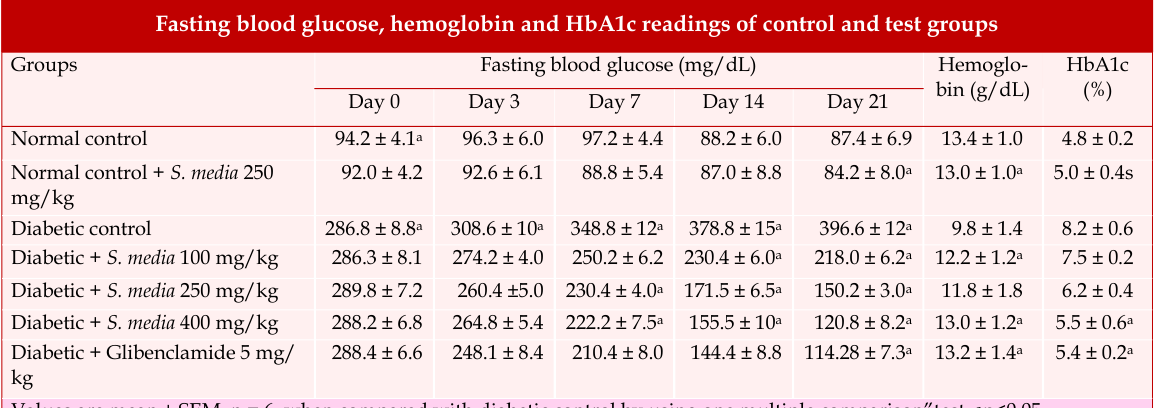
Fasting blood glucose, hemoglobin and HbA1c readings of control and test groups